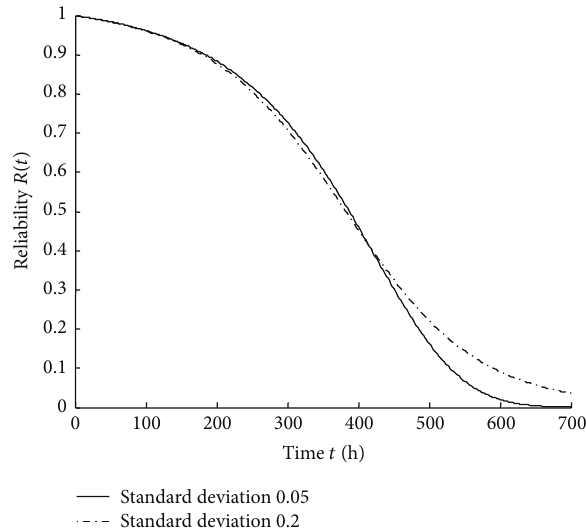
Figure 5: Reliability curves with different standard deviations of 𝑘 .